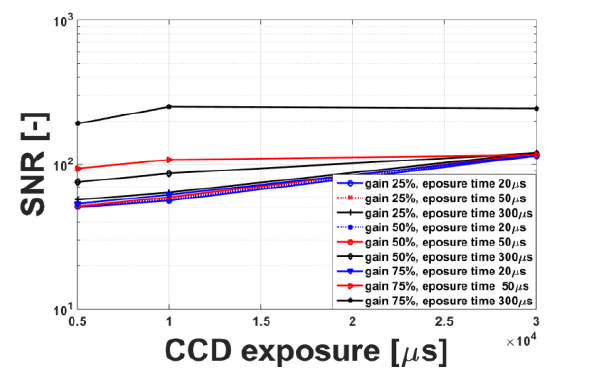
Fig. 13. C 10880-03, 60% gain, exposure time 300µs, contours of acquired image